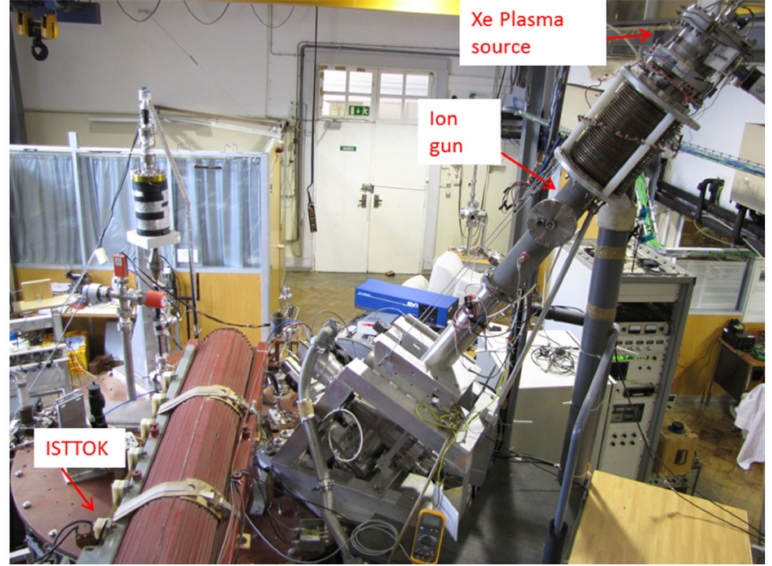
Figure 4. Set-up of the HIBD in ISTTOK